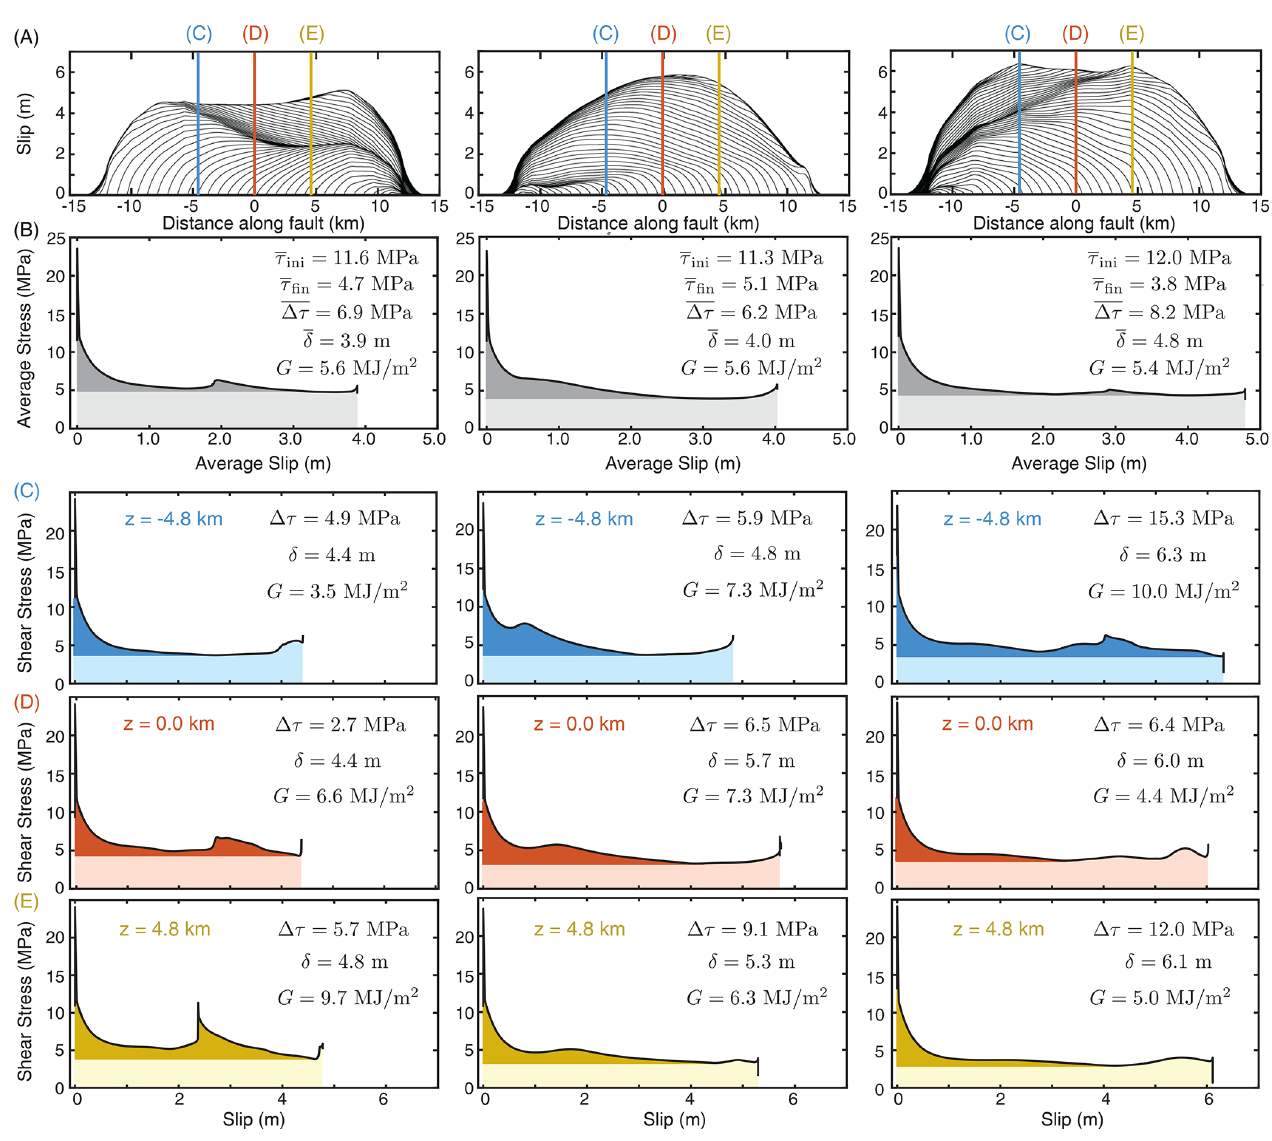
Figure 9. Comparison of local breakdown energy for three large earthquake ruptures with nearly the same average breakdown energy and comparable average slip. (a) Slip distributions for the three ruptures. (b) Average shear stress vs. slip curves, illustrating the energy partitioning of the ruptures. (c–e) Local shear stress vs. slip curves at three points within the ruptures. There is not a strictly increasing trend of breakdown energy with slip for all points. In panel (c) , point z = − 4 . 8km experiences increasing G with increasing slip. However, in panel (e) , point z = 4 . 8km experiences lower values of G in ruptures with larger local